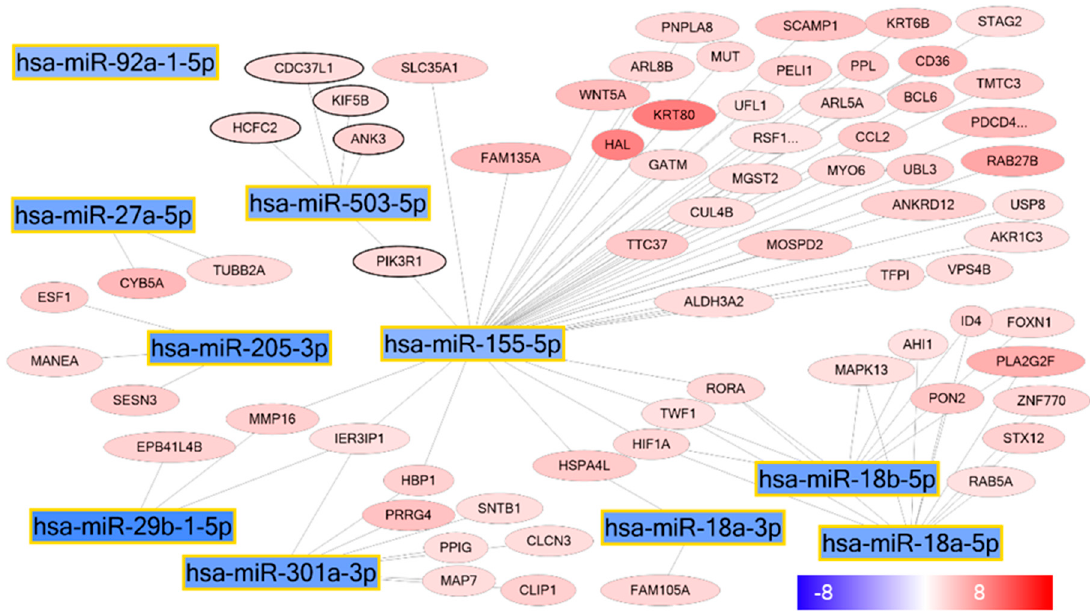
Figure 4. miRNA–mRNA interaction during epidermal differentiation. The interaction network displays the top 10 downregulated miRNAs during epidermal differentiation and targeted upregulated mRNAs. miR-155 encounters a central role in the network with 47 target genes.